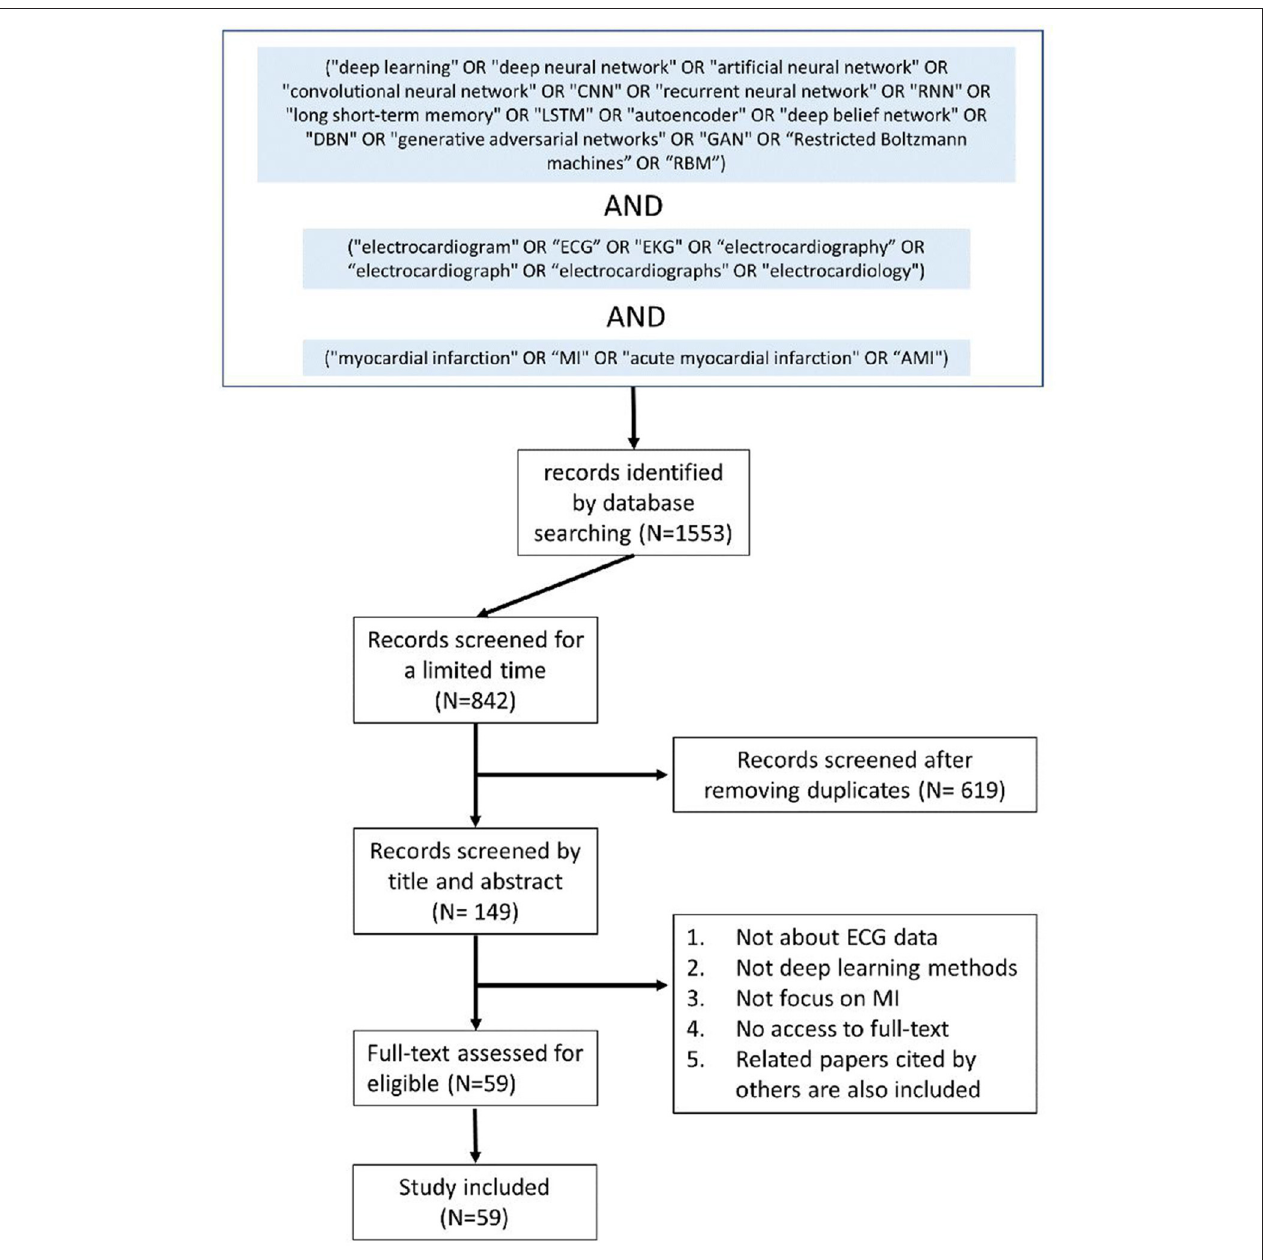
FIGURE 3 | Flow diagram of paper